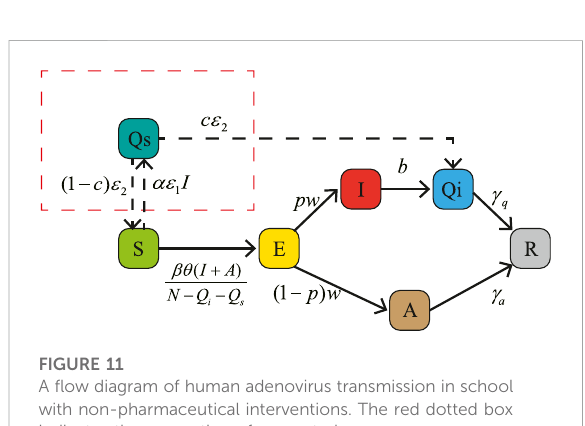
FIGURE 11 A fl ow diagram of human adenovirus transmission in school with non-pharmaceutical interventions. The red dotted box indicates the quarantine of suspected